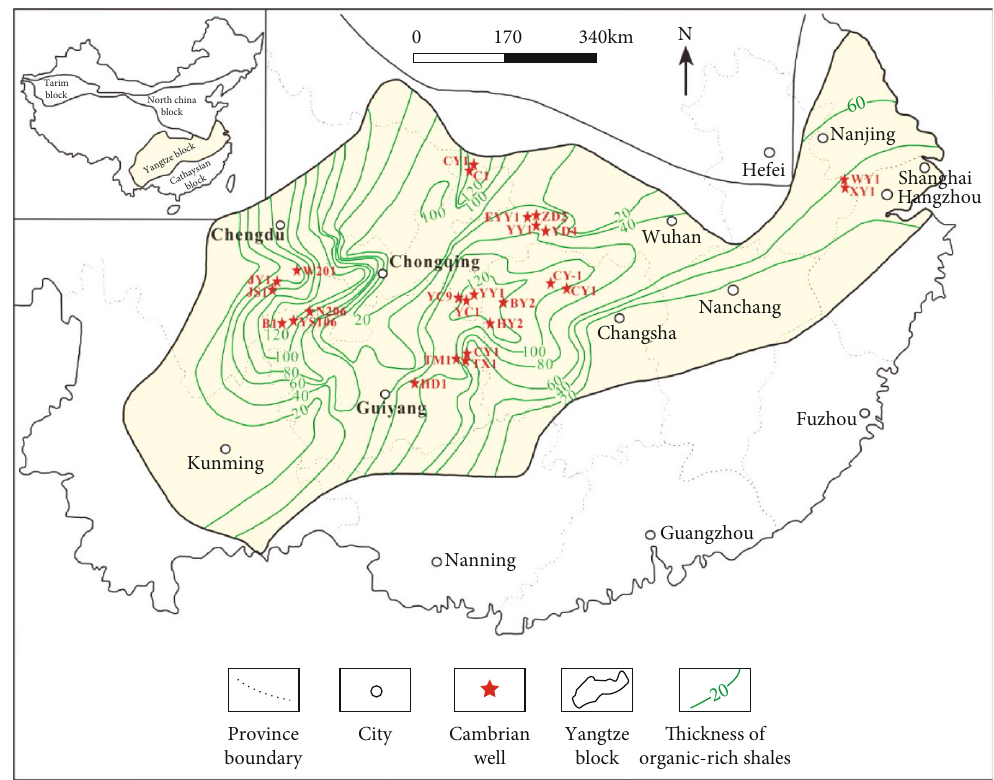
Figure 2: The distribution of the Lower Cambrian shale gas wells, thickness of organic-rich shales. CY-1: Ciye1 Well, CY1 in northern Hunan area: Changye1 Well (modi fi ed from Wu et al. [16]; Zhu et al. [45]; Wang et al.